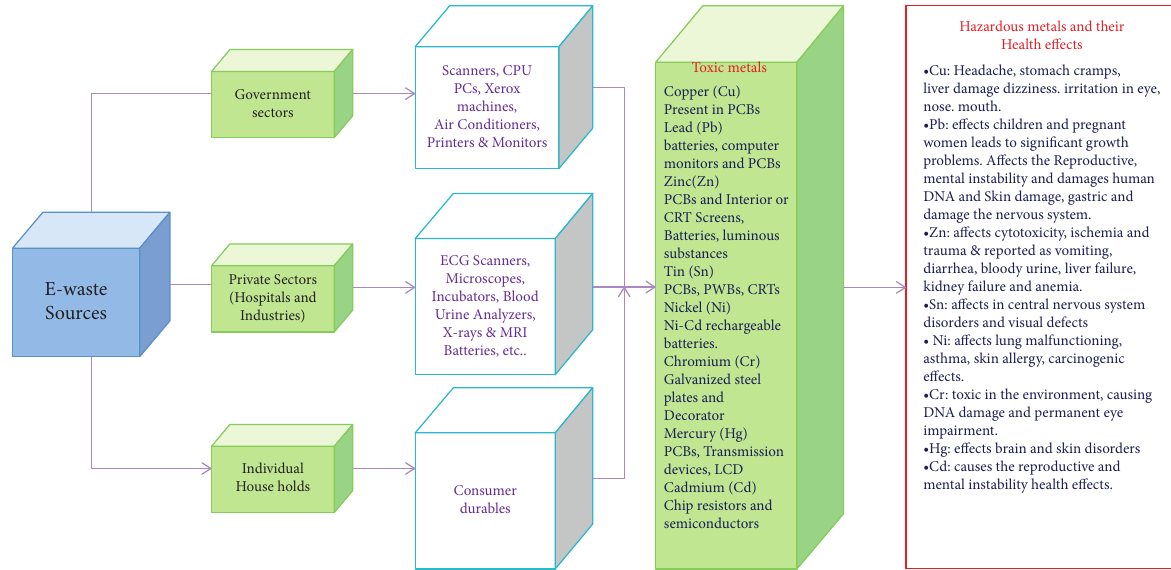
Figure 3: Schematic diagram of E waste sources in various sectors, and their effects on human